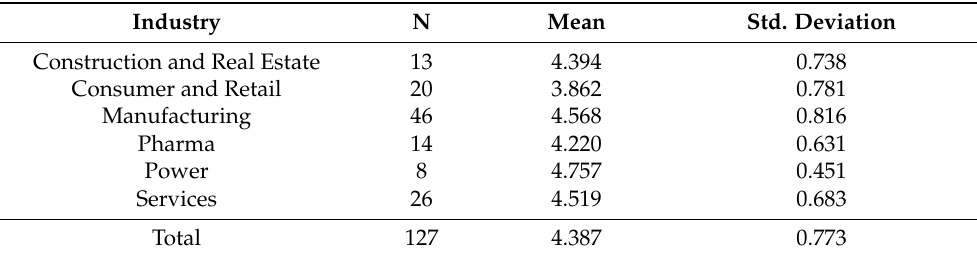
Table 5. Descriptive: One-way